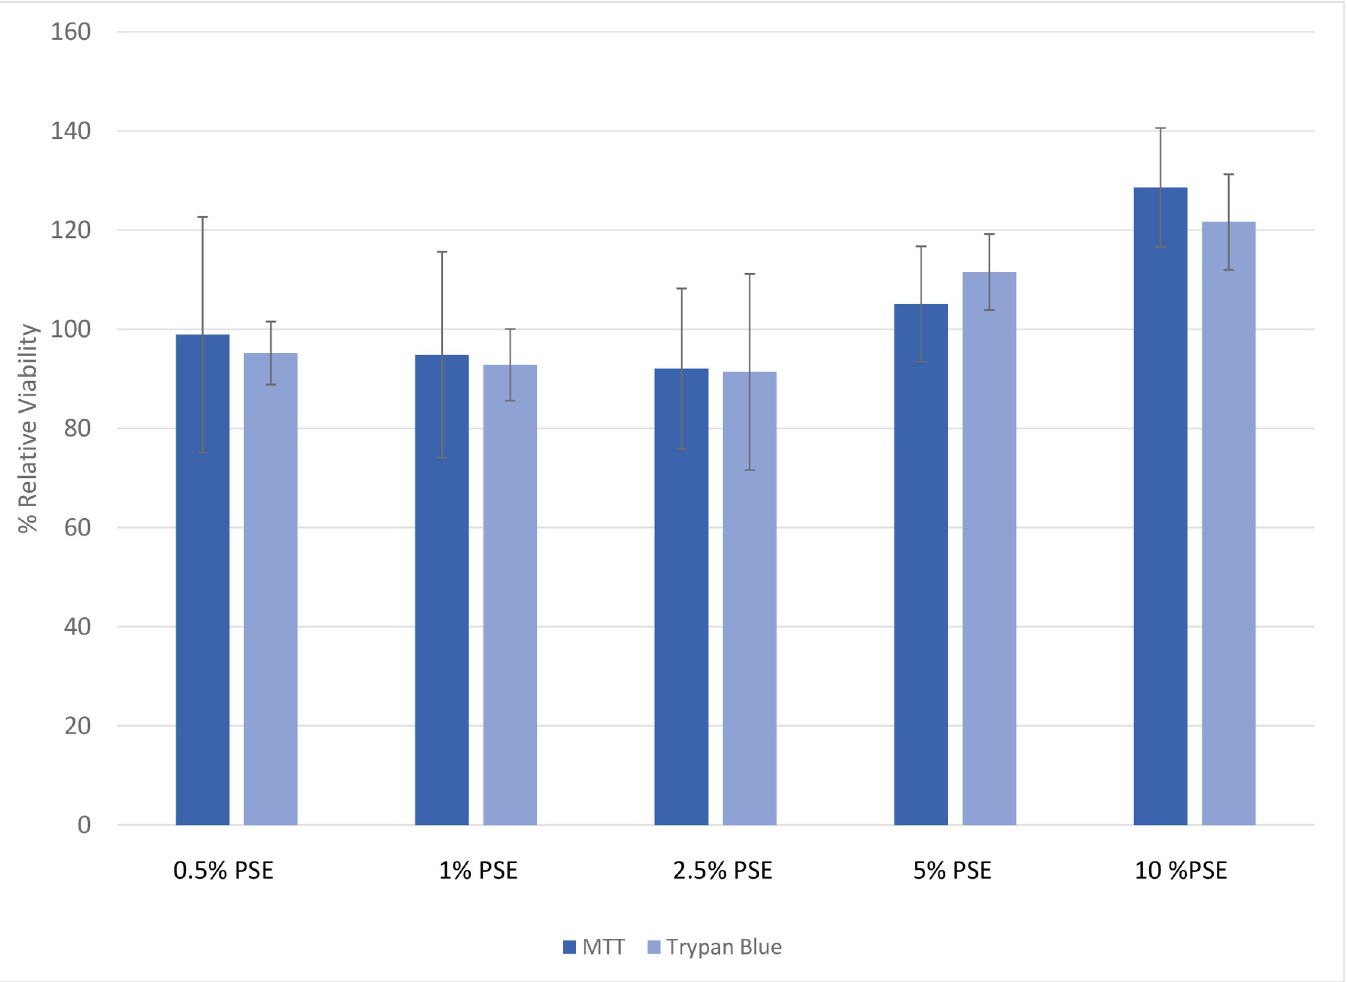
Fig 1. Effects of varying concentrations of PSE on HepG2 cells viability measured by (A) MTT cells growth assay and (B) trypan blue exclusion method. HepG2 cells were exposed to varying concentrations of peanut skin extract (0–10%) for 24 hours and their viability was determined. The viability of the control was assumed to be 100% and the data are expressed as viability relative to the control. Each treatment was done in triplicate for both methods and the data is expressed as mean ± SEM. � Indicates statistically significant difference at P < 0.05.